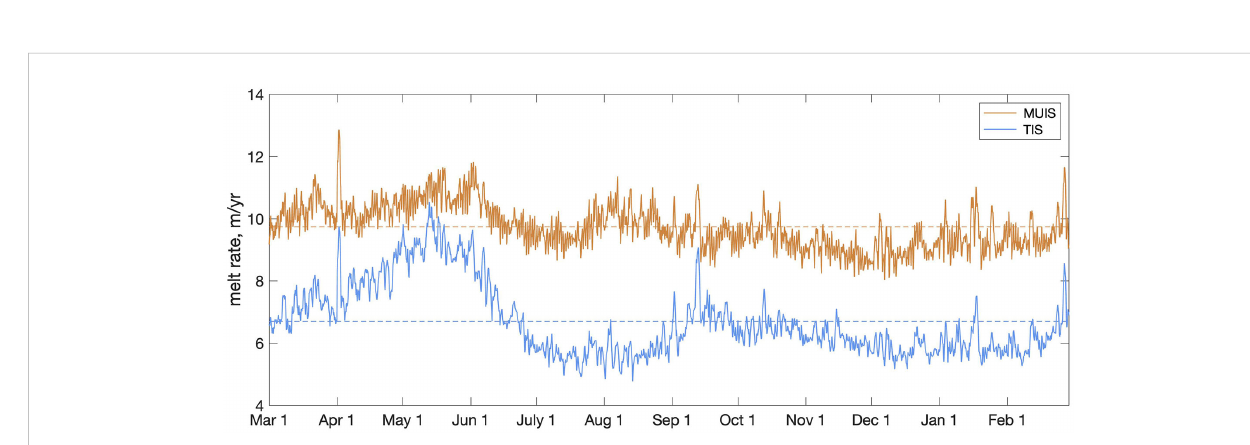
FIGURE 2 The area-averaged melt rate (m/year) time series for the 2014 simulation year and the annual mean line showed in dashed lines of TIS (in blue), and MUIS (in